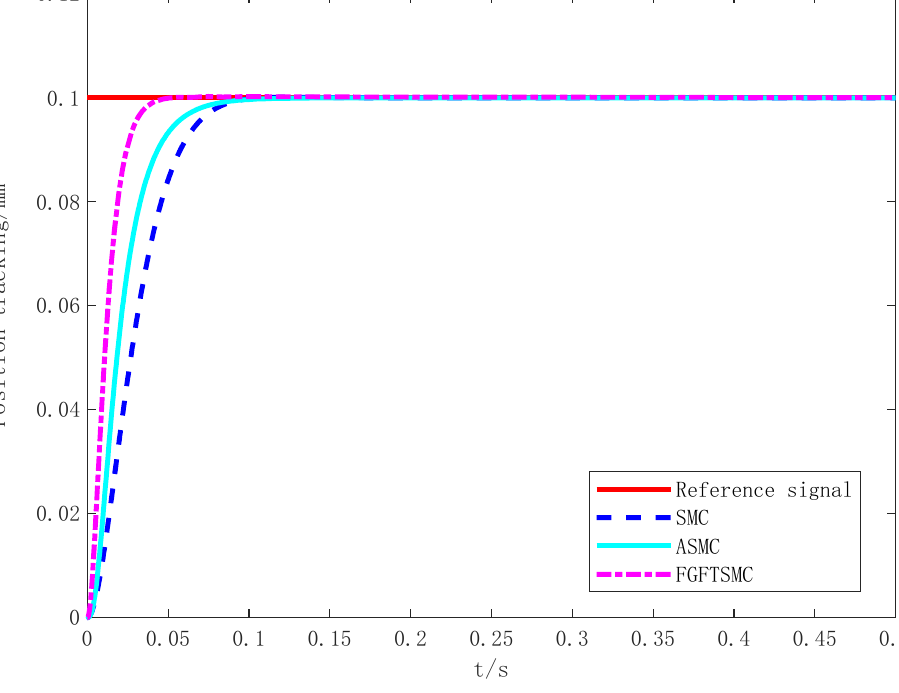
Figure 5. Comparison of position tracking curves.